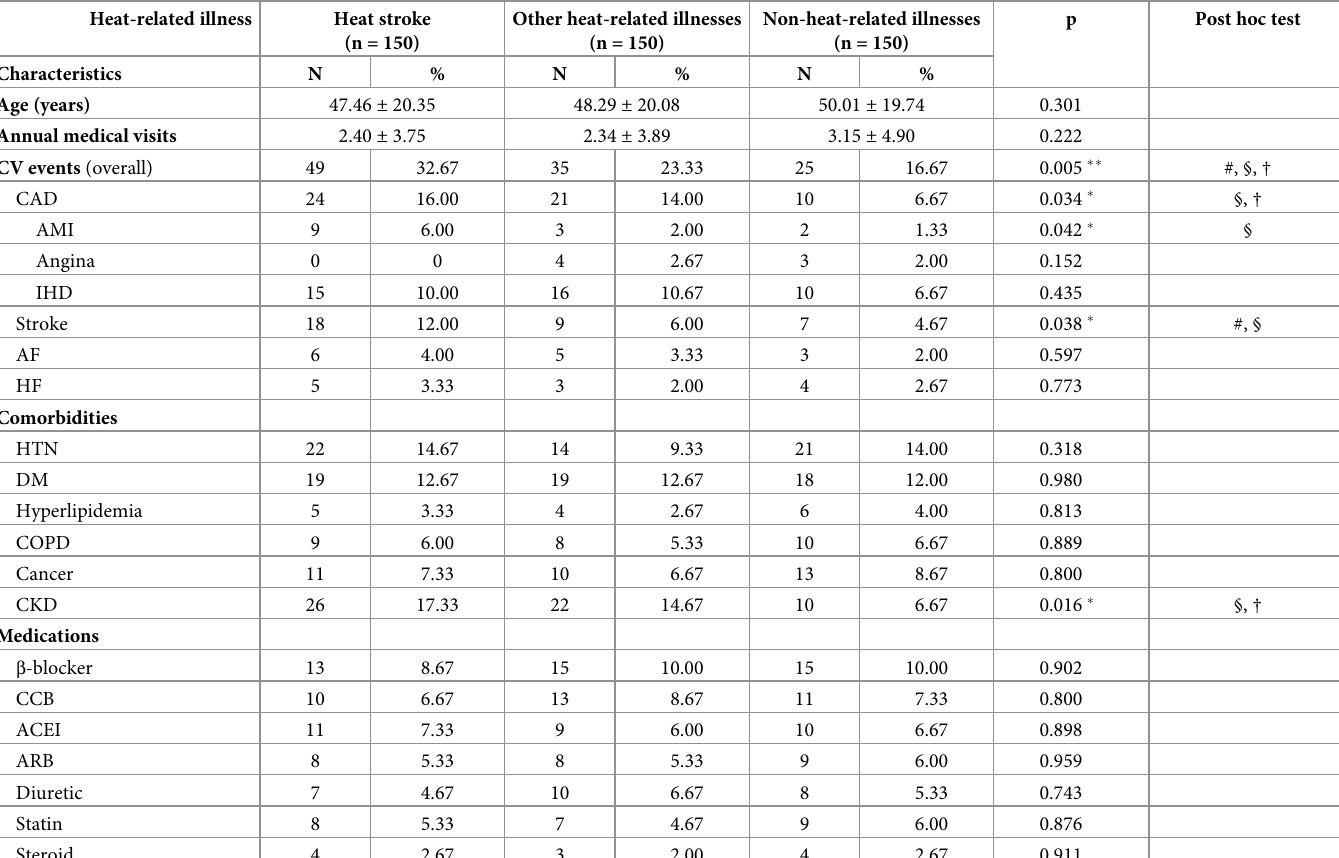
Table 2. Cardiovascular events and characteristics during the 14-Year follow-up